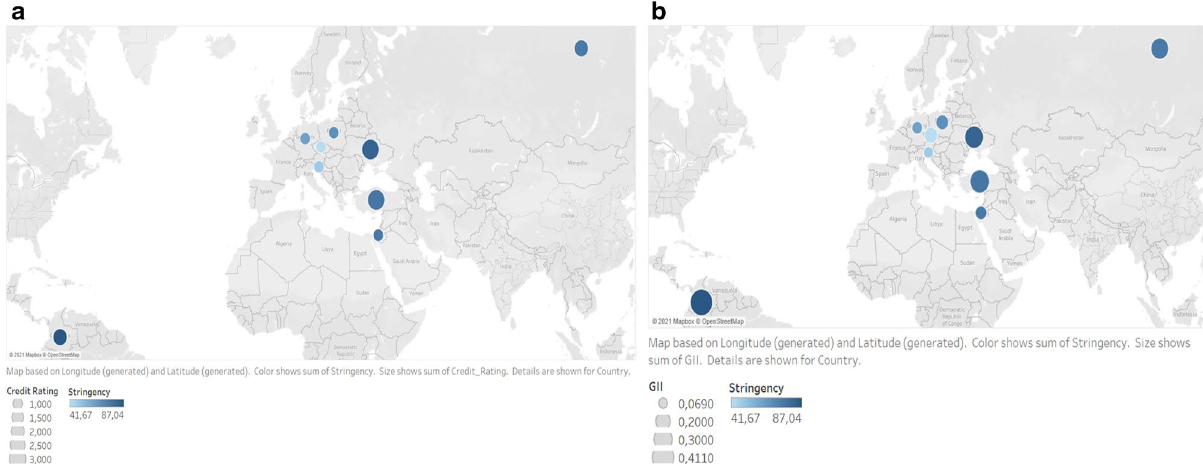
Figure 1. Maps present the following data in nine countries (Poland, Slovenia, Czechia, Ukraine, Russia, Germany, Turkey, Israel, and Colombia): ( a ) credit rating (indicated by the size of the dot) and the stringency level of restrictions (highlighted in color); ( b ) gender Inequality Index (GII) (size) and the stringency level (color). The map was developed in Tableau